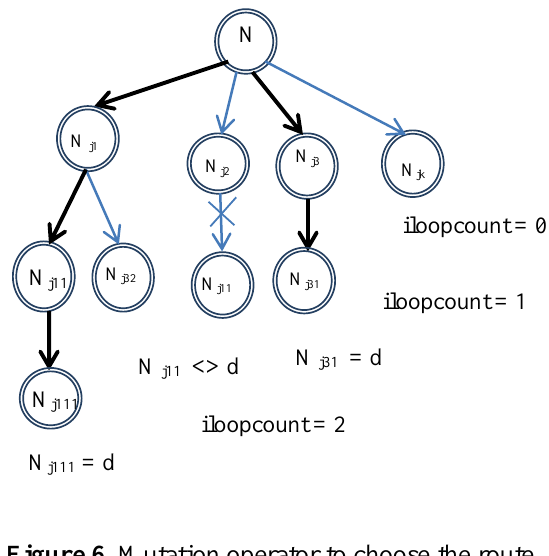
Figure 6. Mutation operator to choose the route.